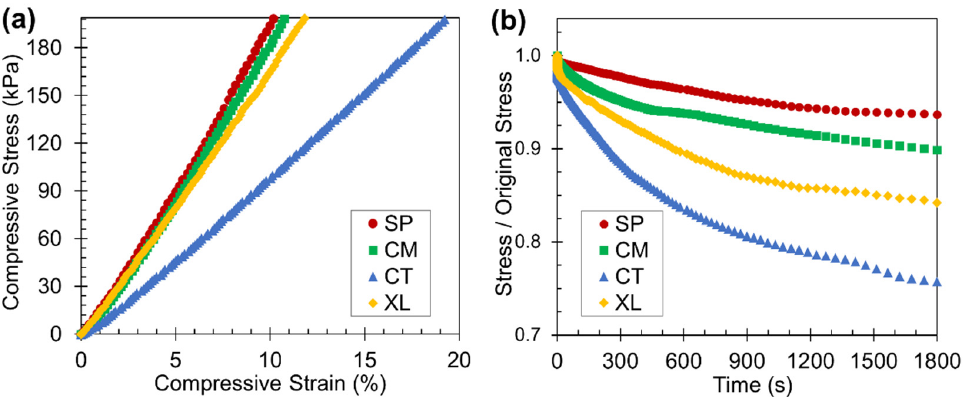
Figure 8. Results from the static compression testing displaying the ( a ) stress-stain curves (truncated at a compressive stress of 200 kPa) and ( b ) stress relaxation curves of the four foam samples with 6.5 wt% CFA at room temperature. 6.5 wt% CFA at room